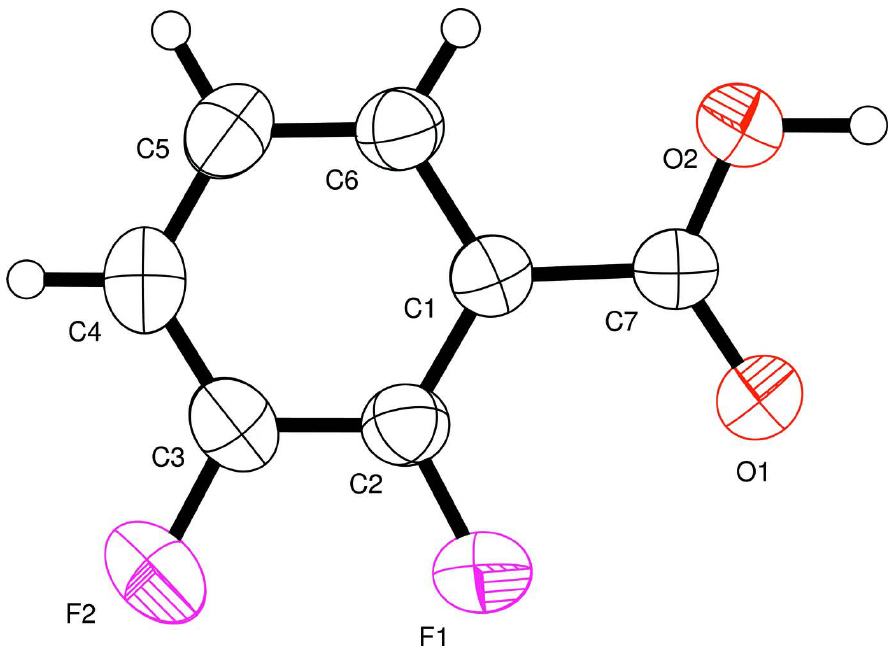
Figure 1 An asymmetric unit of 2,3-difluorobenzoic acid. Displacement ellipsoids are drawn at the 50% probability level, while hydrogen atoms are drawn as spheres of an arbitrary radius.